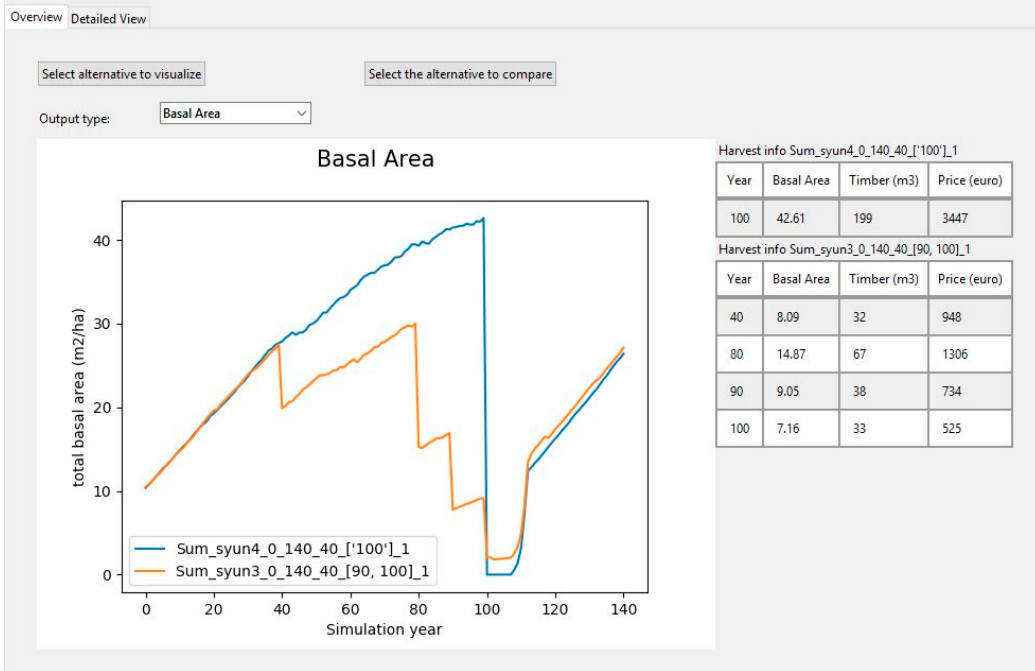
3 Figure 8. Visualization user interface. The overview tab facilitates the comparison of the stand under two simulated alternatives. The figure shows the evolution of the basal area for the two alternatives, displayed through graphs, complemented with the tabular harvest information.